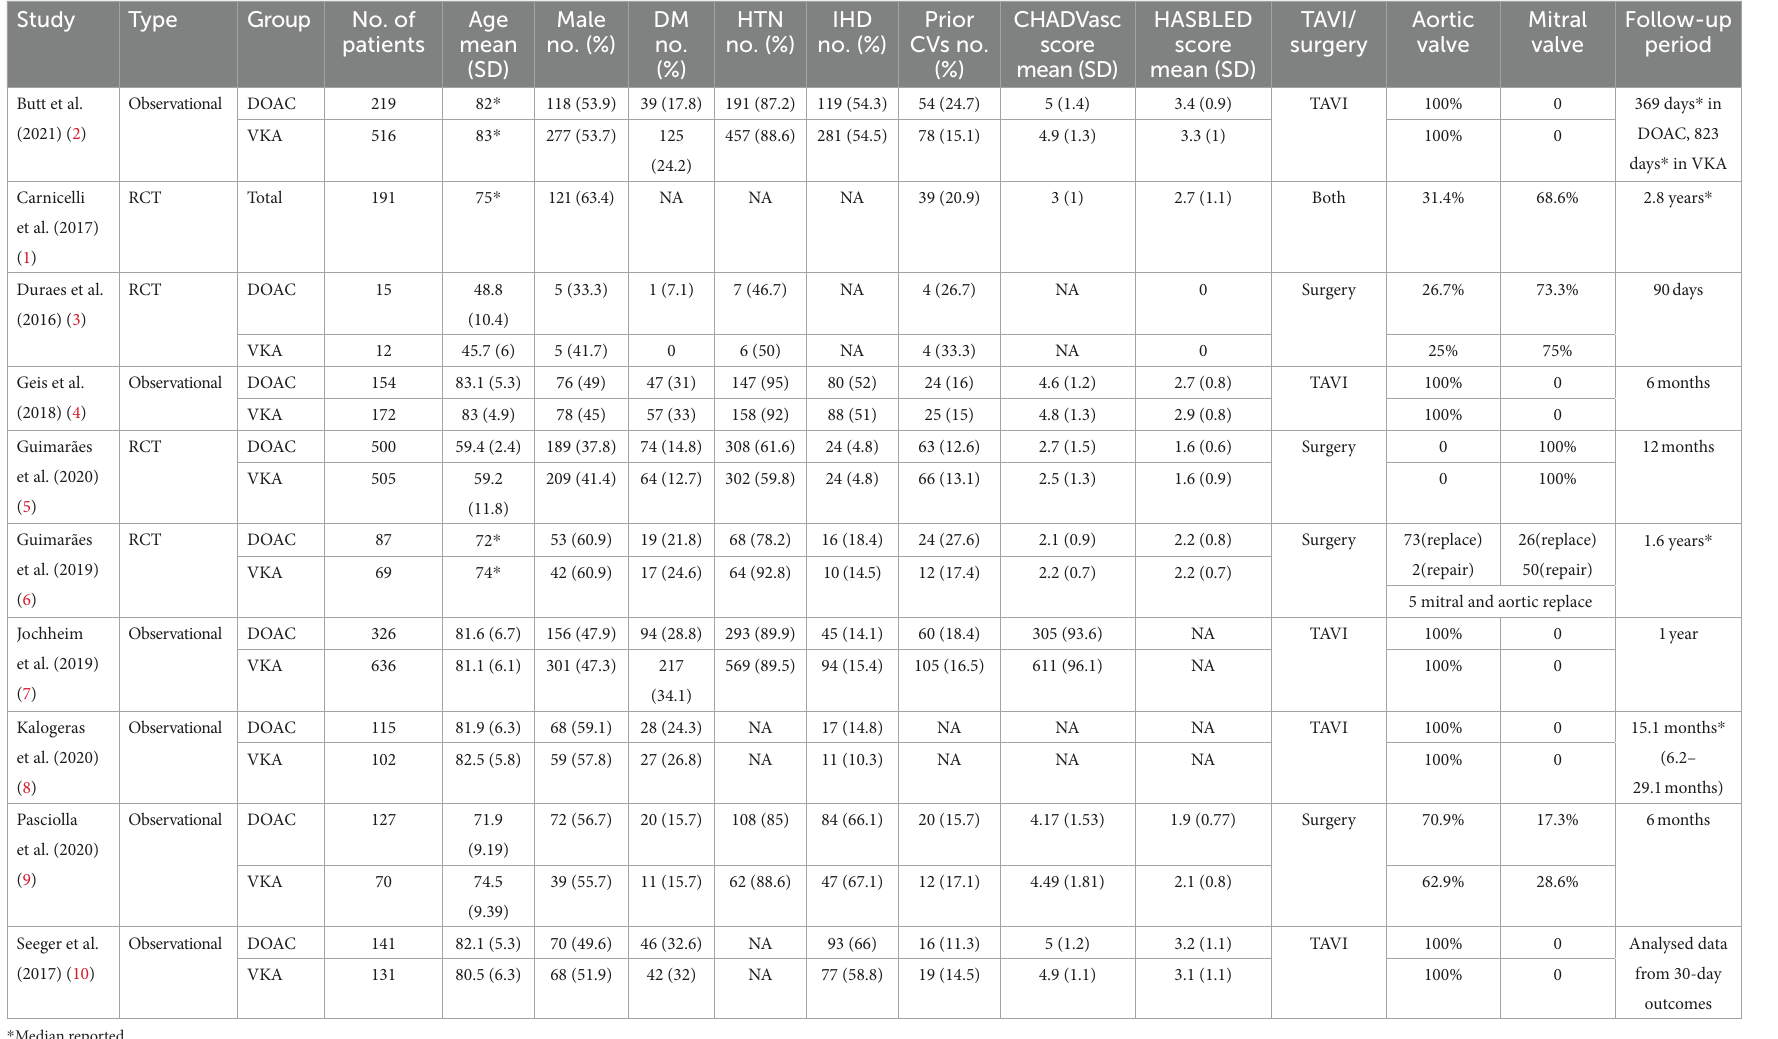
TABLE 1 Baseline characteristics of the population in the included